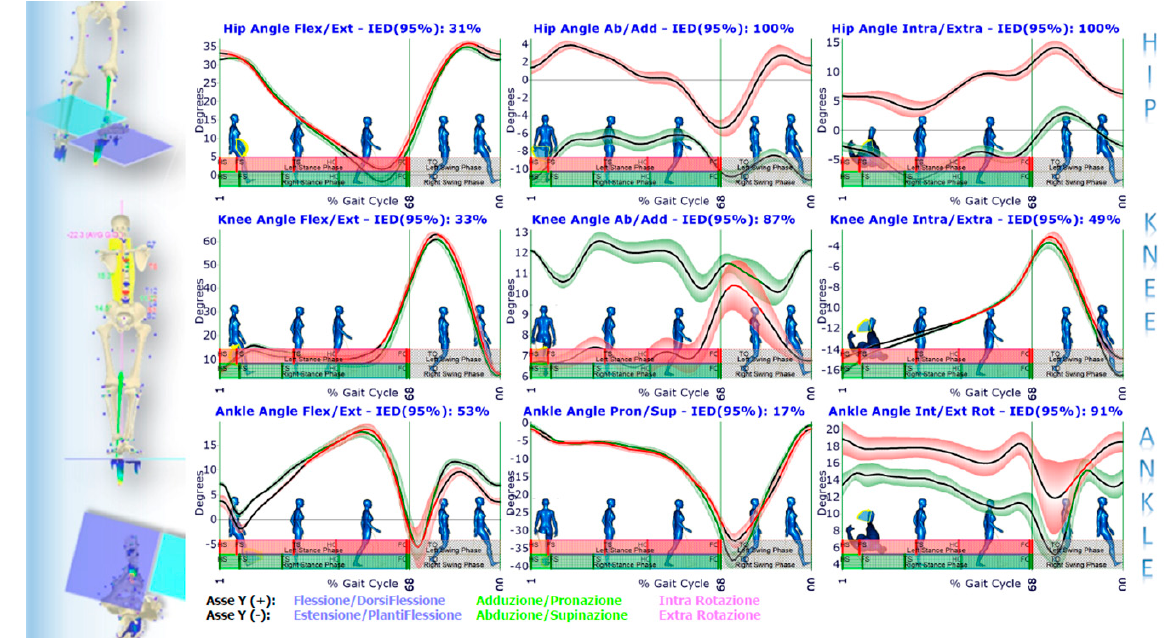
Figure 8. Mean gait cycle: lower limb joint angles. The left (red colour) vs. right leg (green colour) comparison during barefoot walking at the first evaluation is represented. IED values at the top of each panel quantify and summarise the percentage of gait asymmetry per each angle at each joint level. The black coloured lines sub-regions highlight where the left (red colours) vs. right (green colours) variable’s temporal courses point-by-point t -Test is significant ( p < 0.05).